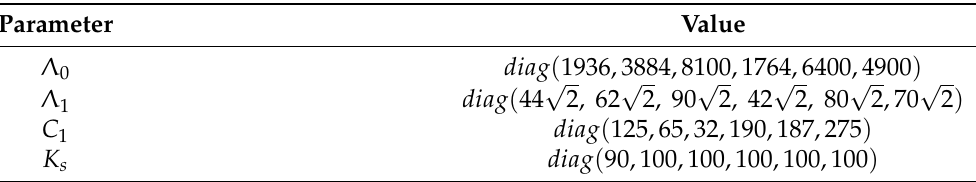
Table 1. Sliding mode controller (SMC) parameters.